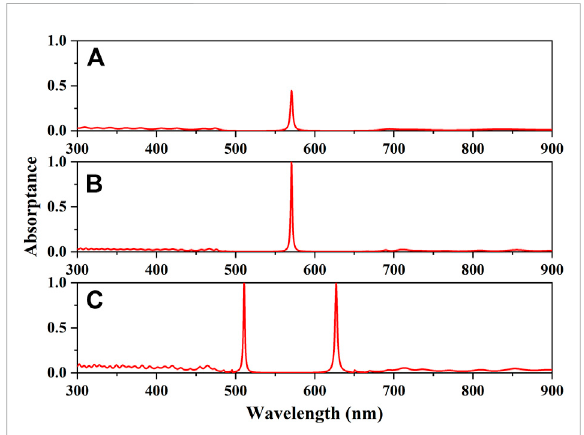
FIGURE 2 AbsorptionspectraofthePC(AB) M D(BA) N withk D =0.006. (A) Symmetrical PC (AB) 5 D(BA) 5 with d D = 138.28 nm. (B) AsymmetricalPC(AB) 5 D(BA) 20 withd D =138.28 nm. (C) (AB) 5 D(BA)